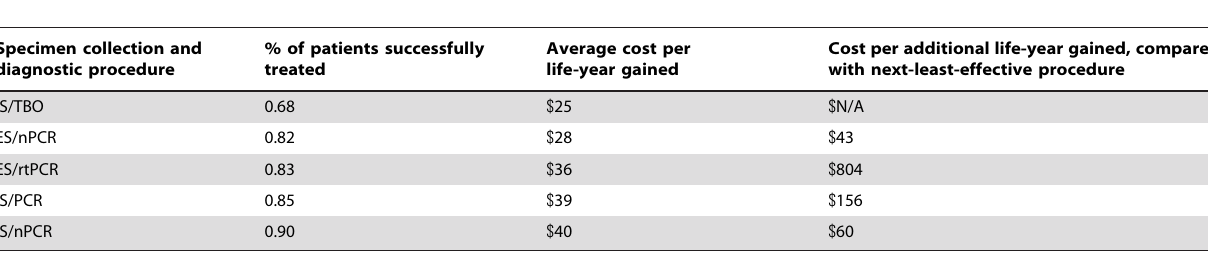
Table 3. Incremental cost-effectiveness of a subset of diagnostic procedures for Pneumocystis pneumonia, assuming 50% disease